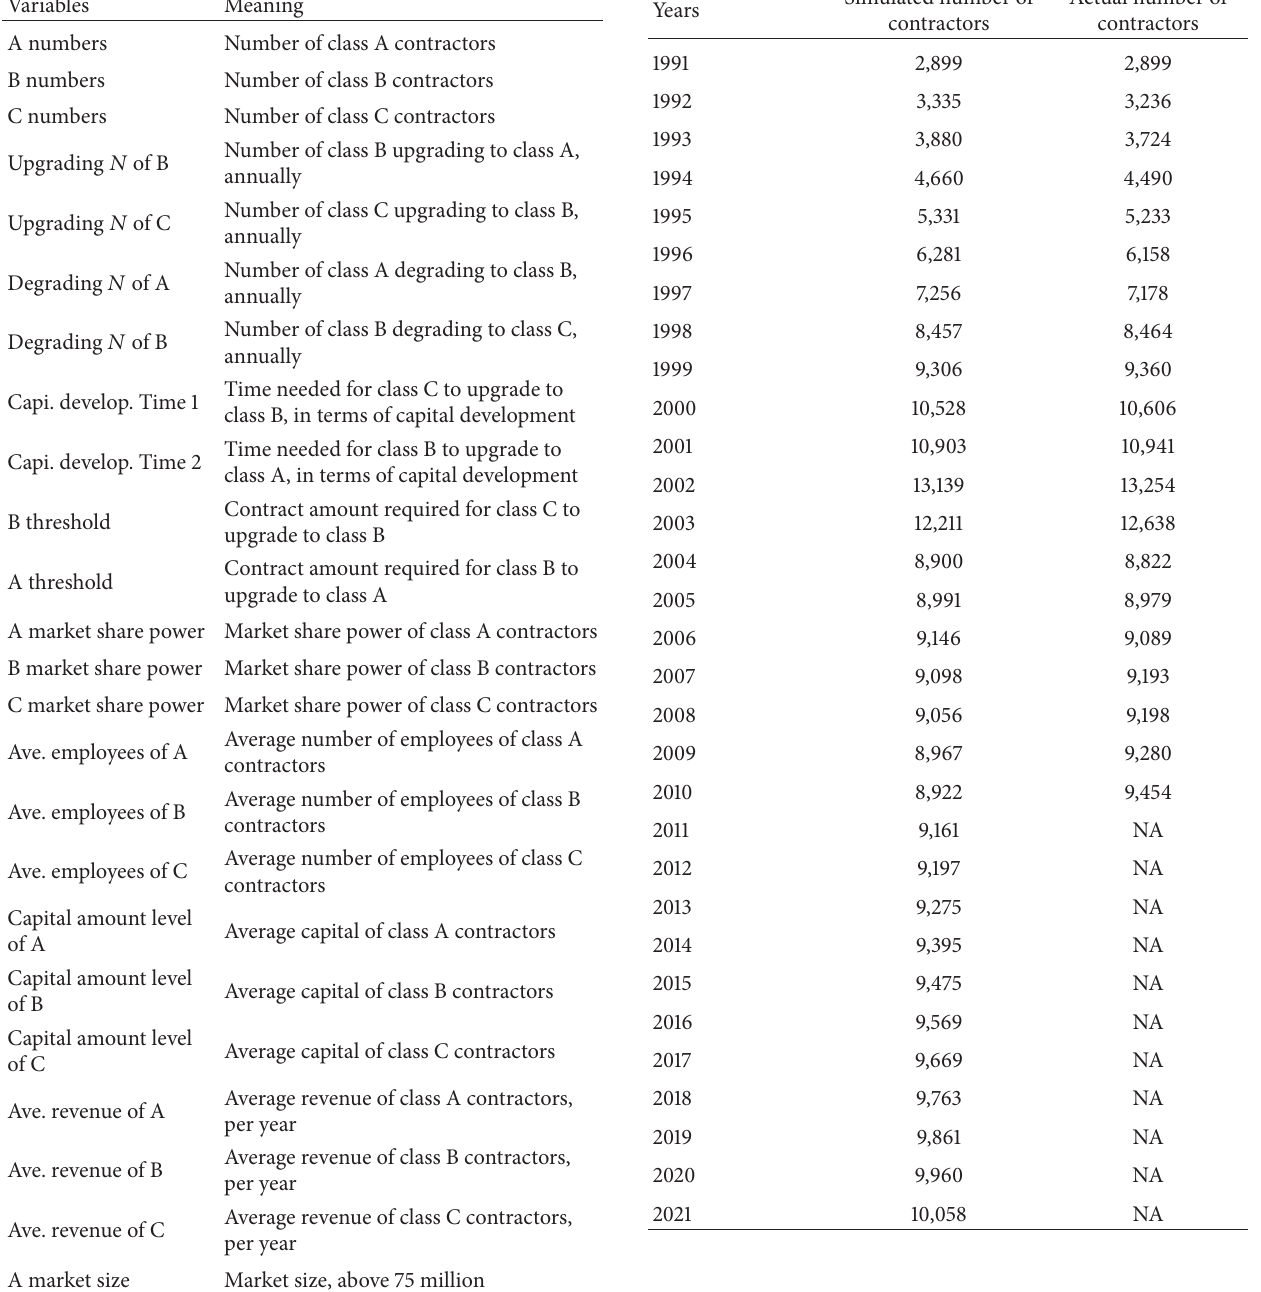
(MAPE), the results indicate that dynamically simulated esti- mates employing the proposed model can achieve excellent precision, and therefore the configuration of the model